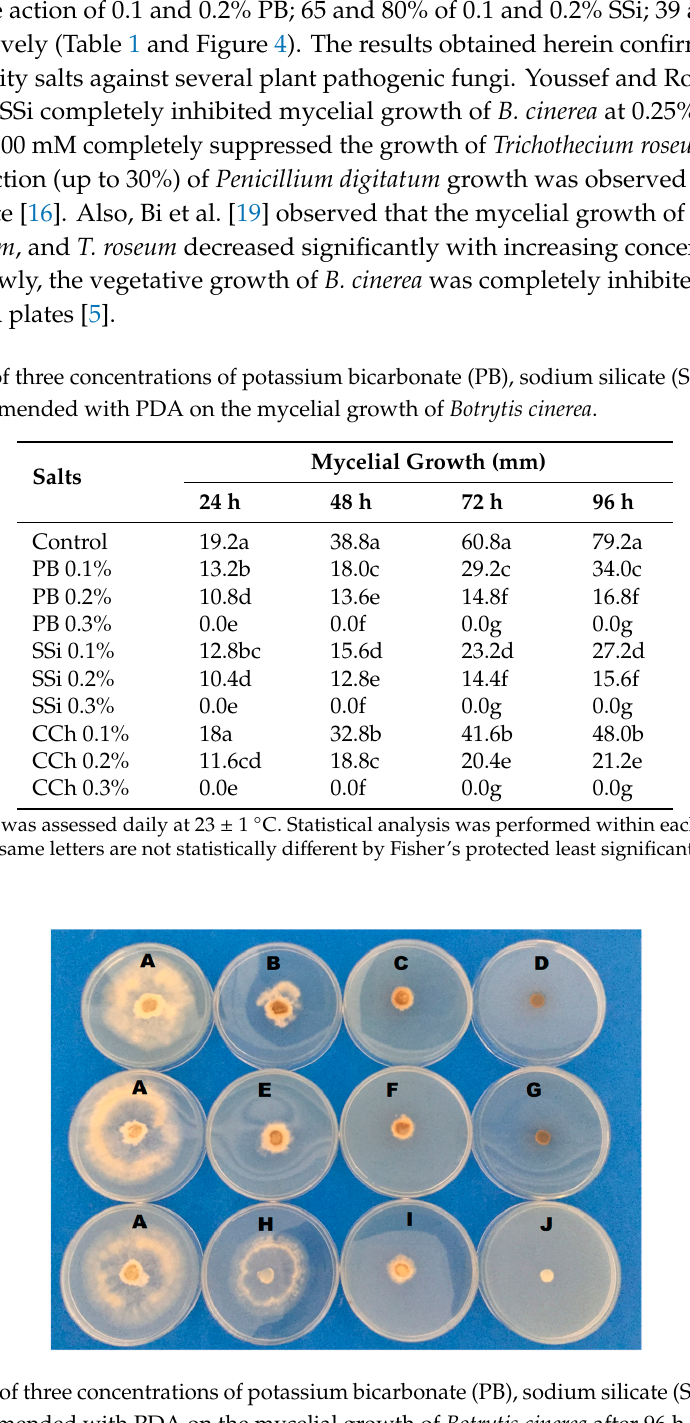
Table 1. E ff ect of three concentrations of potassium bicarbonate (PB), sodium silicate (SSi), and calcium